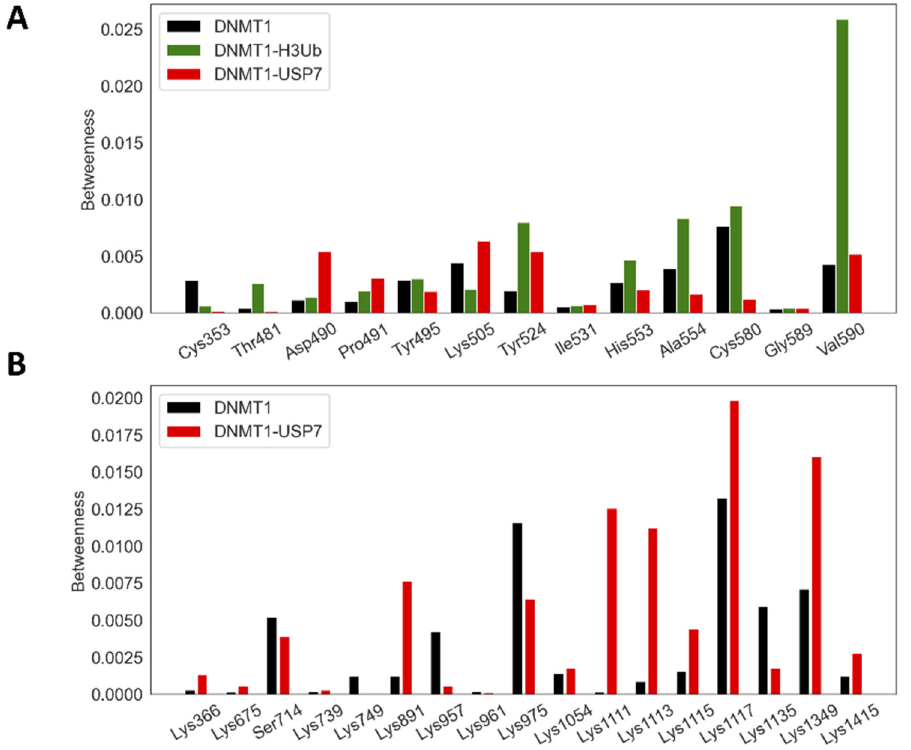
Figure 8. The comparison of BC values for ( A ) each disease mutation in three DNMT1 systems and ( B ) PTM sites in DNMT1 and DNMT1-USP7.